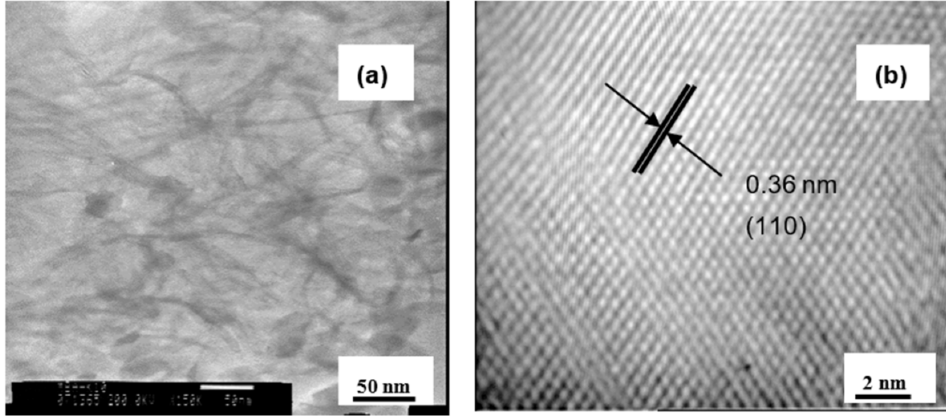
Figure 3. Images of TON nanotubes with ( a ) TEM and ( b ) HR-TEM. The anatase TiO 2 nanotubes (TON) were used as adsorbents for the SPE of Cu (II) from water samples. Factors that may influence the extraction yields of the copper ions namely the type, volume, concentration, and flow rate of elution solvents, were studied. Likewise, the volume, pH, and flow rate of percolated samples and the effect of the mass of the adsorbent were